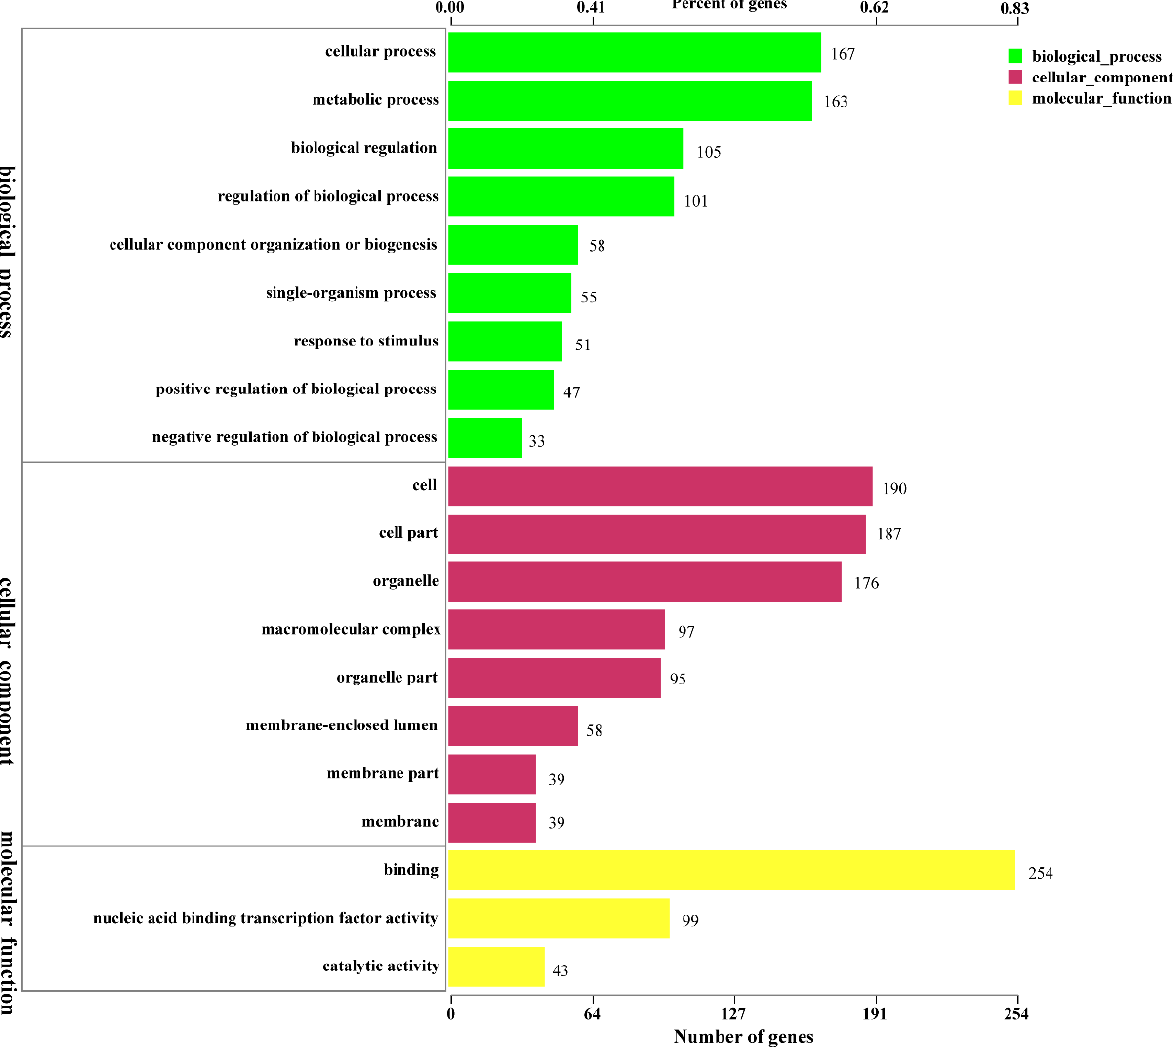
Figure 5 . Classification of GO annotations in yeast YF1503. The x-axis shows the number of